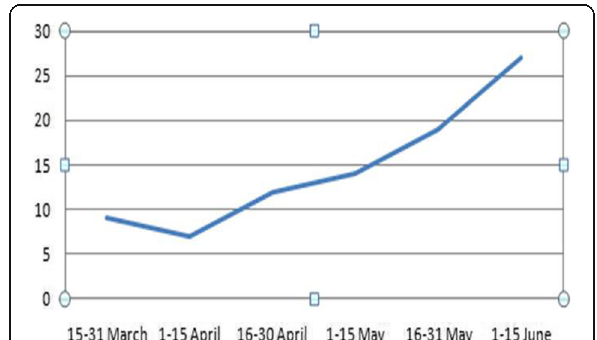
Fig. 8 Line chart representation of the number of patients with recognized COVID-19-associated pneumonia in their routine oncologic 18F-FDG PET/CT examinations during the study period (the Y axis represents the number of cases, and the X axis represents the study time interval)